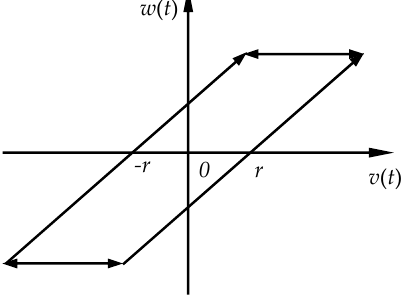
Figure 2. The input–output relationship of the Play operator.